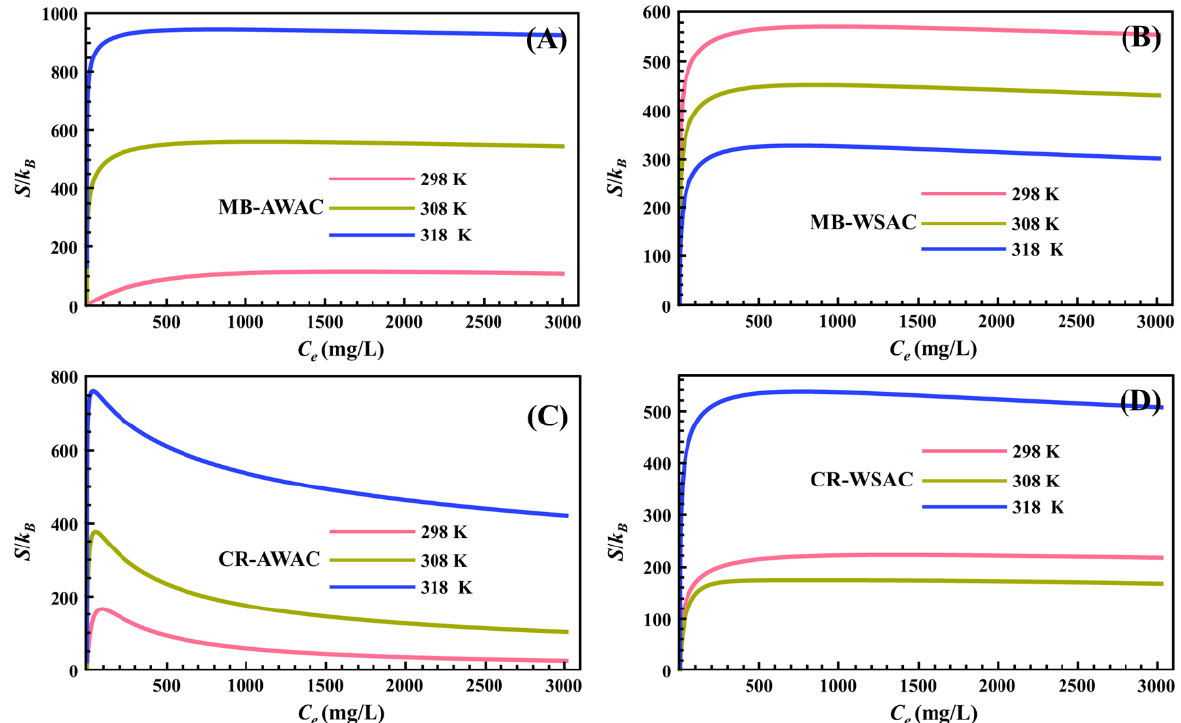
Figure 2. Entropy ( S ) evolution with dye concentration for MB-AWAC ( A ), MB-WSAC ( B ), CR- AWAC ( C ), and CR-WSAC ( D ) adsorption systems.